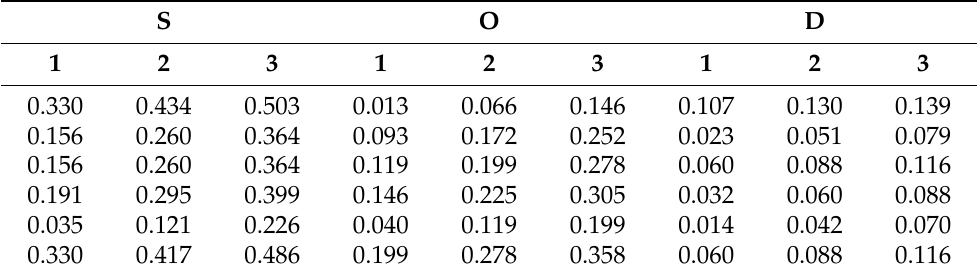
Table 10. WSM decision matrix.